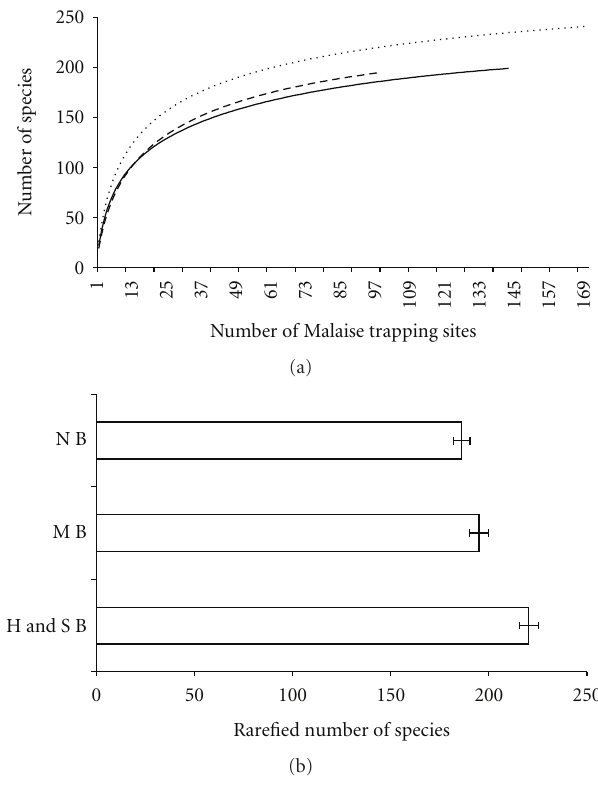
Figure 6: Rarefied regional species richness of Finnish crane flies (Diptera, Tipuloidea) based on Malaise trapping data (see Table 1), here arranged according to ecoregions. (a) Sample-based rarefaction curves, dot line = hemi- and south boreal, dashed line = middle boreal, and solid line = north boreal. Standard deviations are not shown. (b) Rarefied species richness at the level of 101 traps, means, and SDs. H and S B = hemi- and south boreal, M B = middle boreal, and N B = north boreal